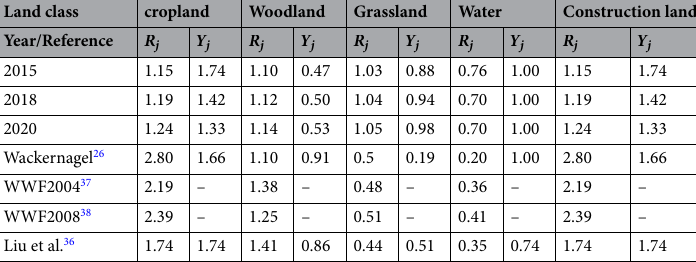
Table 5. Yield factor and balance factor of each land type in Yellow River